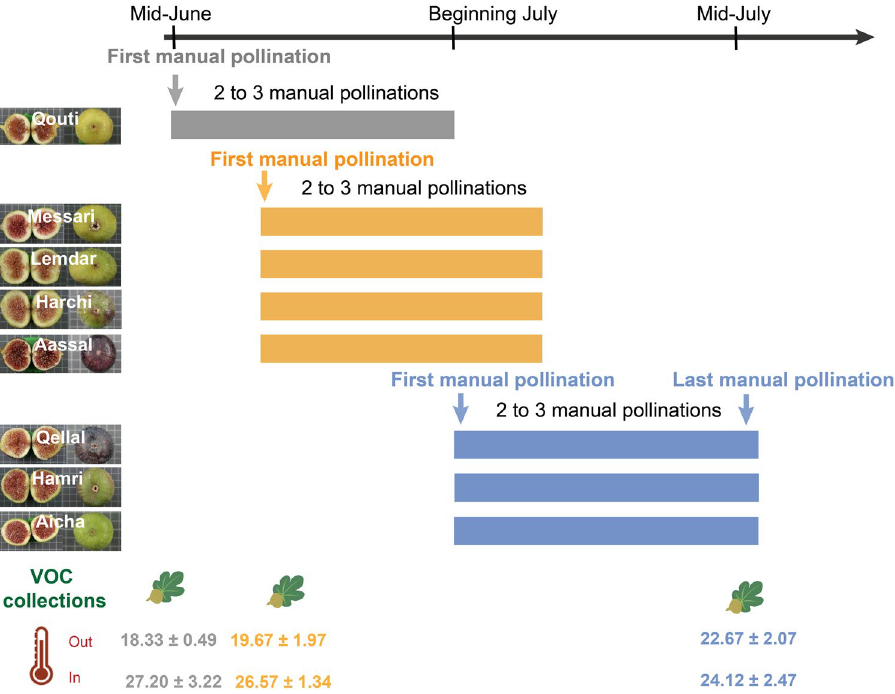
Figure 1. Diagram showing the timing of manual pollination and of collection of volatile organic compounds (VOCs) from receptive figs for the eight varieties of Ficus carica studied. The time of the year is indicated by the black arrow at the top of the diagram. For each variety, the first manual pollination time is indicated and each individual tree was pollinated two to three more times over a period of two to three weeks. Varieties with the same color (grey: Beginning; yellow: Middle; blue: End) experienced the first manual pollination at the same time. Three VOC collection sections of the same six individual trees per variety were made (indicated by the drawing of the figs). For each of these sections, the mean (± standard errors) per individual tree of the temperatures inside (in) and outside (out) the bag containing the figs are presented in degrees